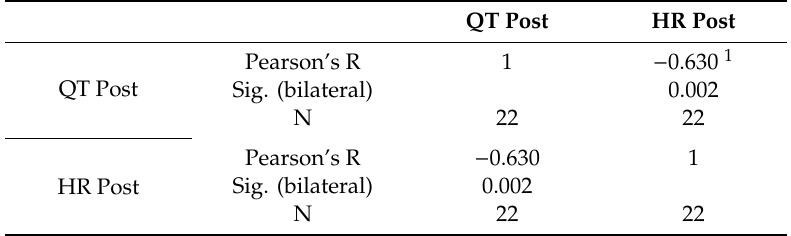
Table 5. Pearson’s correlation coe ffi cient for the post-exercise QT Interval and HR. QT Post HR Post Pearson’s R 1 − 0.630 1 QT Post